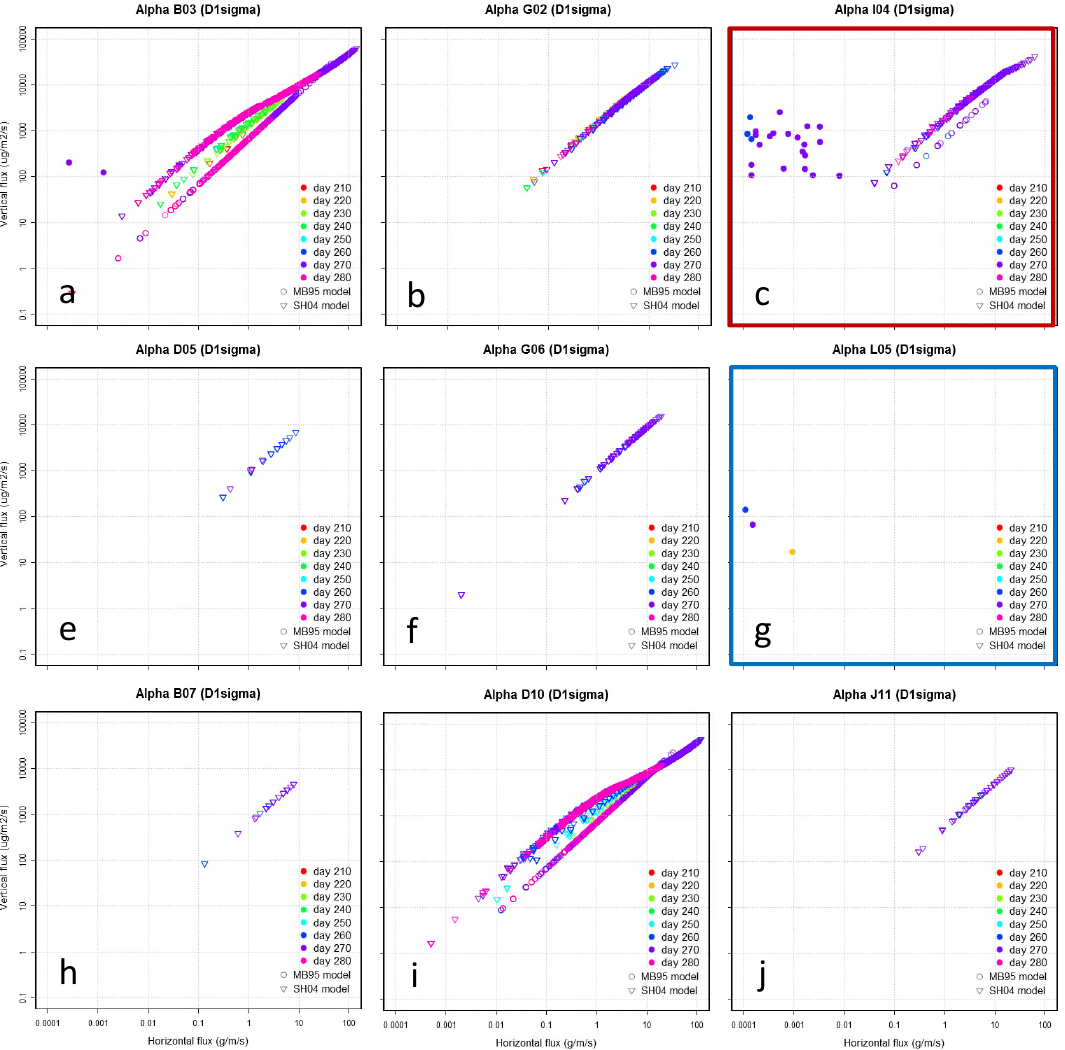
Figure 6. The temporal evolution of the simulated vertical-to-horizontal flux ratio α for Exp. 1a (open circles) and 4a (open triangles) is shown in comparison to the observed values (closed circles). The colour refers to 10 day time intervals during the field season, with the start DOY given for each period. Nine out of 11 field sites are shown. In cases of F OBS without simultaneous Q OBS , α is zero. Note that there are situations in which vertical emission flux was measured without saltating